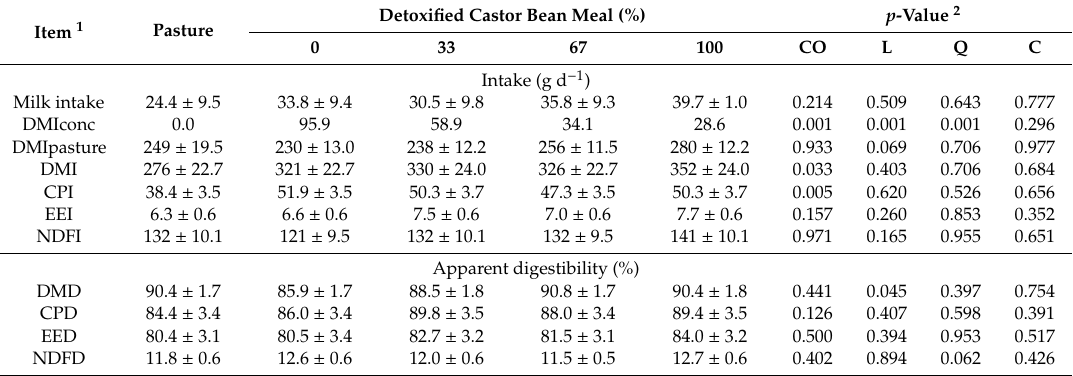
Table 5. Nutrient intake and apparent digestibility (mean ± SD) of diets supplemented with or without castor bean meal via a creep-feeding method.